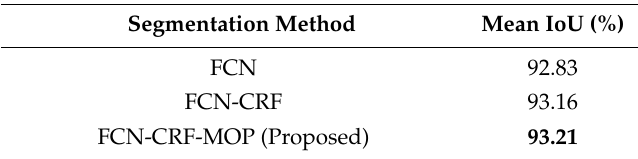
Table 1. A comparison of different segmentation models under mean IoU (Intersection over Union). The highest result is highlighted in